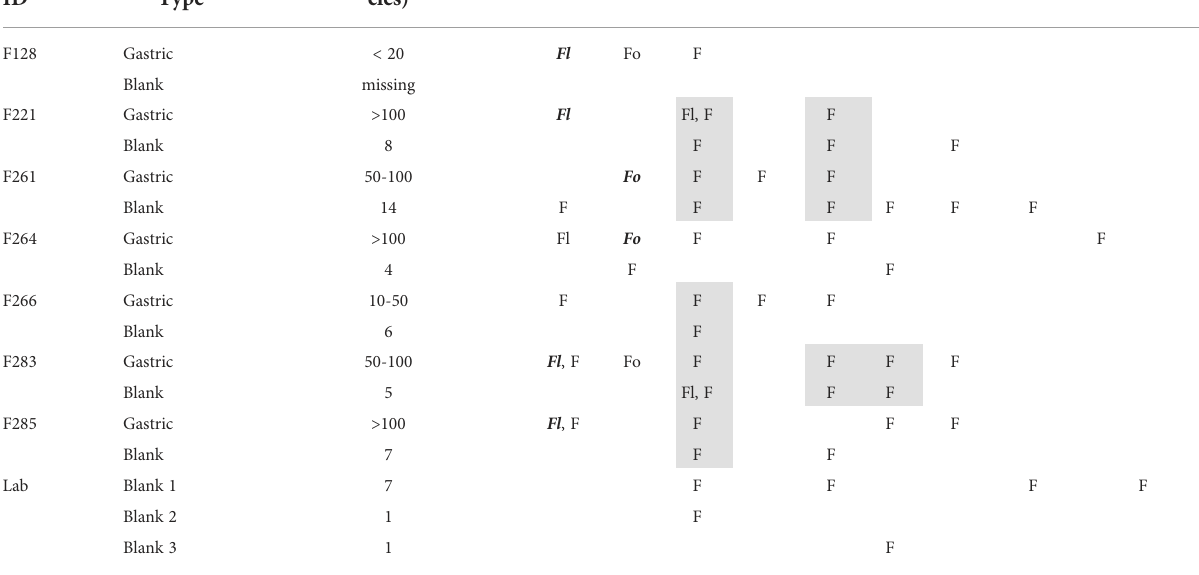
TABLE 3 Microplastic characteristics in environmental/laboratory blanks and gastric samples collected during catch and release bottlenose dolphin health assessments conducted in Sarasota Bay, FL, USA (June 2019).